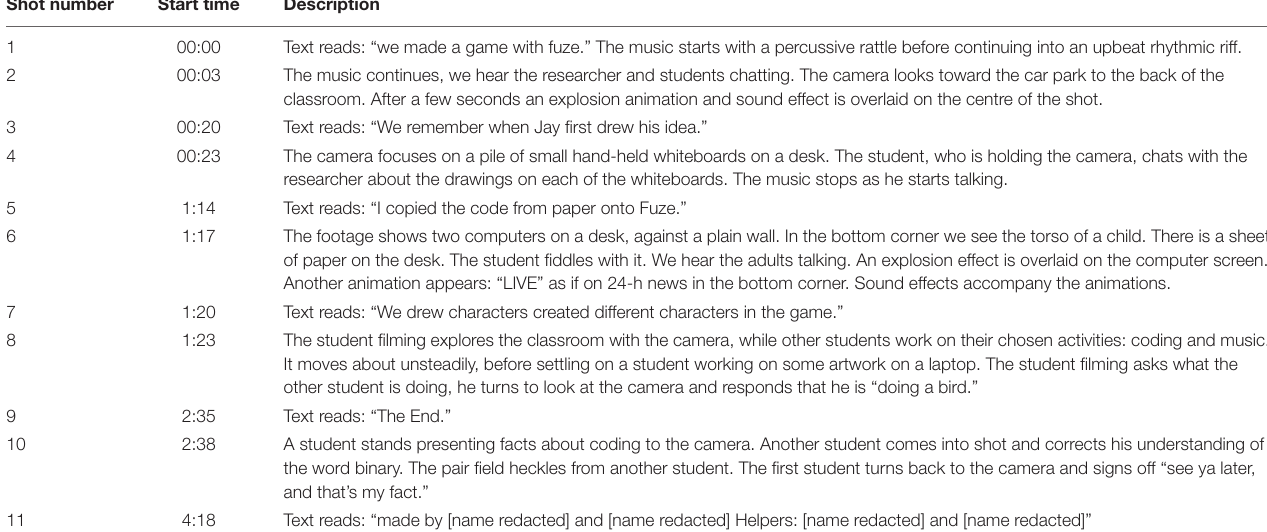
TABLE 1 | Overview of Jay and Terry’s Digital Story about making “Birds with Guns”.